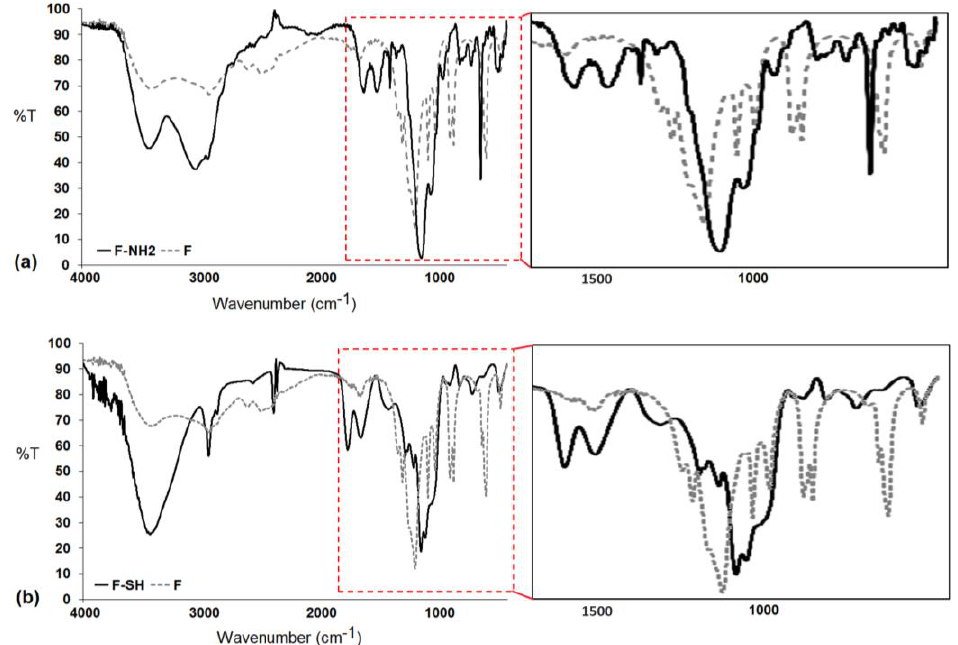
Figure 5. Fourier transform infrared (FTIR) spectra of ( a ) the diatom frustules before and after chemical functionalization with APTES molecules (in the right side, the region between 1800 cm − 1 and 500 cm − 1 is magnified); ( b ) the diatom frustules before and after chemical functionalization with MPTMS molecules (in the right side, the region between 1800 cm − 1 and 500 cm − 1 is magnified).